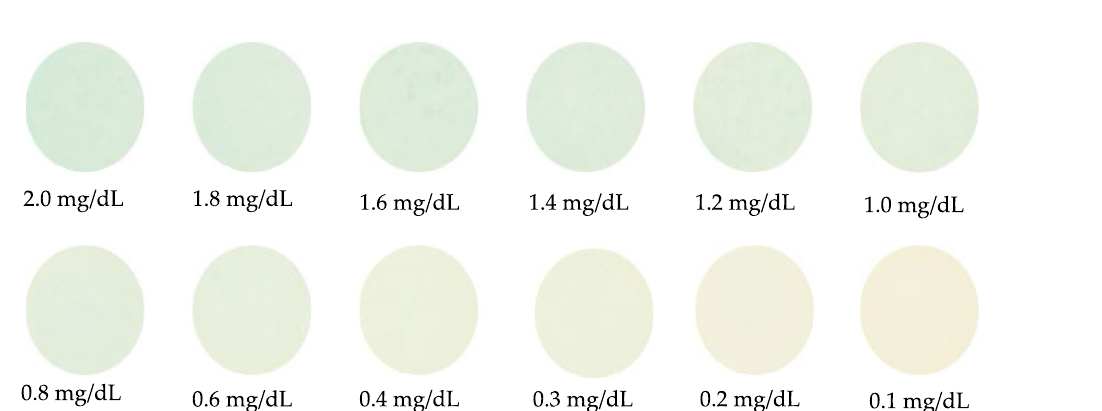
Fig. 10 Color images of test papers with different bilirubin concentrations while using Mini-LEDs as the light source Fig. 11 Linear relationship between different concentra- tions of direct bilirubin and average grayscale of the G channel while using Mini- LEDs as the light